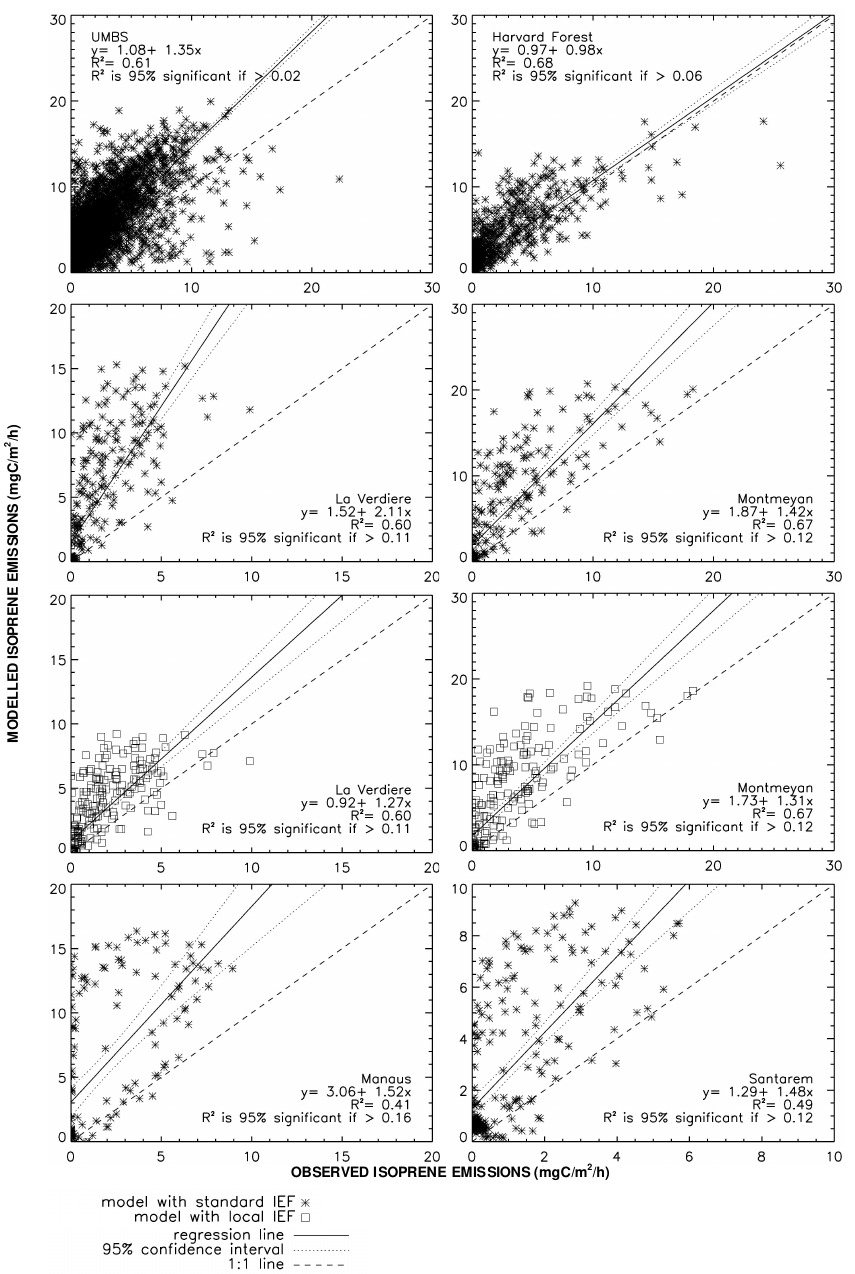
Fig. 2. Scatter plots of simulated and ground-based measured hourly isoprene emissions at the flux tower sites listed in Table 1, including regression line, 95% confidence interval (Scheffe’s method) and 1:1 line. Isoprene emissions were simulated using standard isoprene emission factors (IEFs) from Guenther et al. (1995) and local IEFs when available (second row of